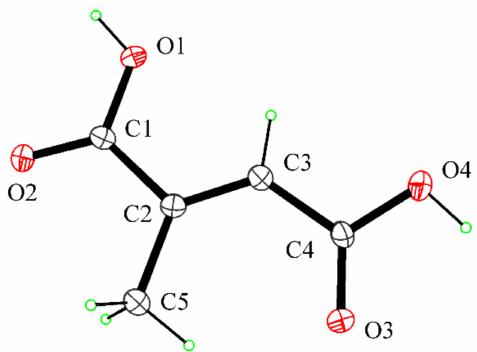
Figure 5. ORTEP view of the molecular structure of 2 . Thermal ellipsoids were drawn at the 30% probability